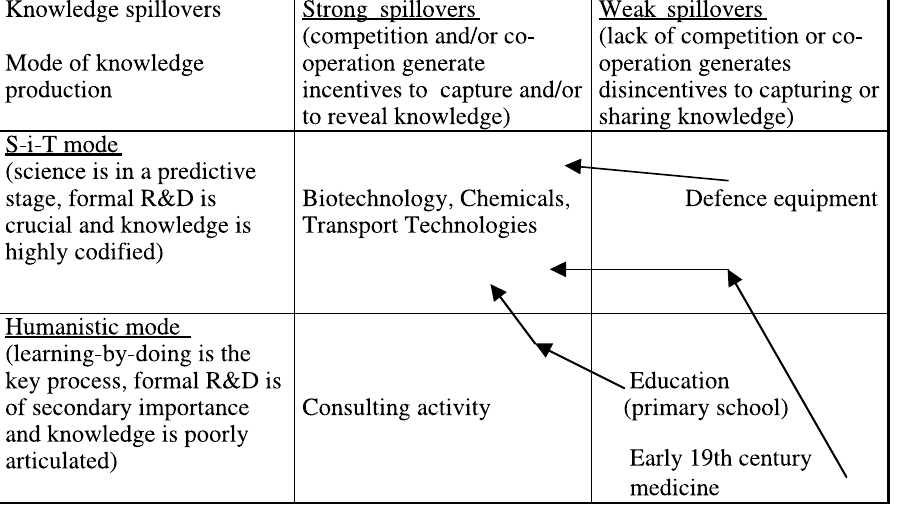
Figure 2. Examples of developmental